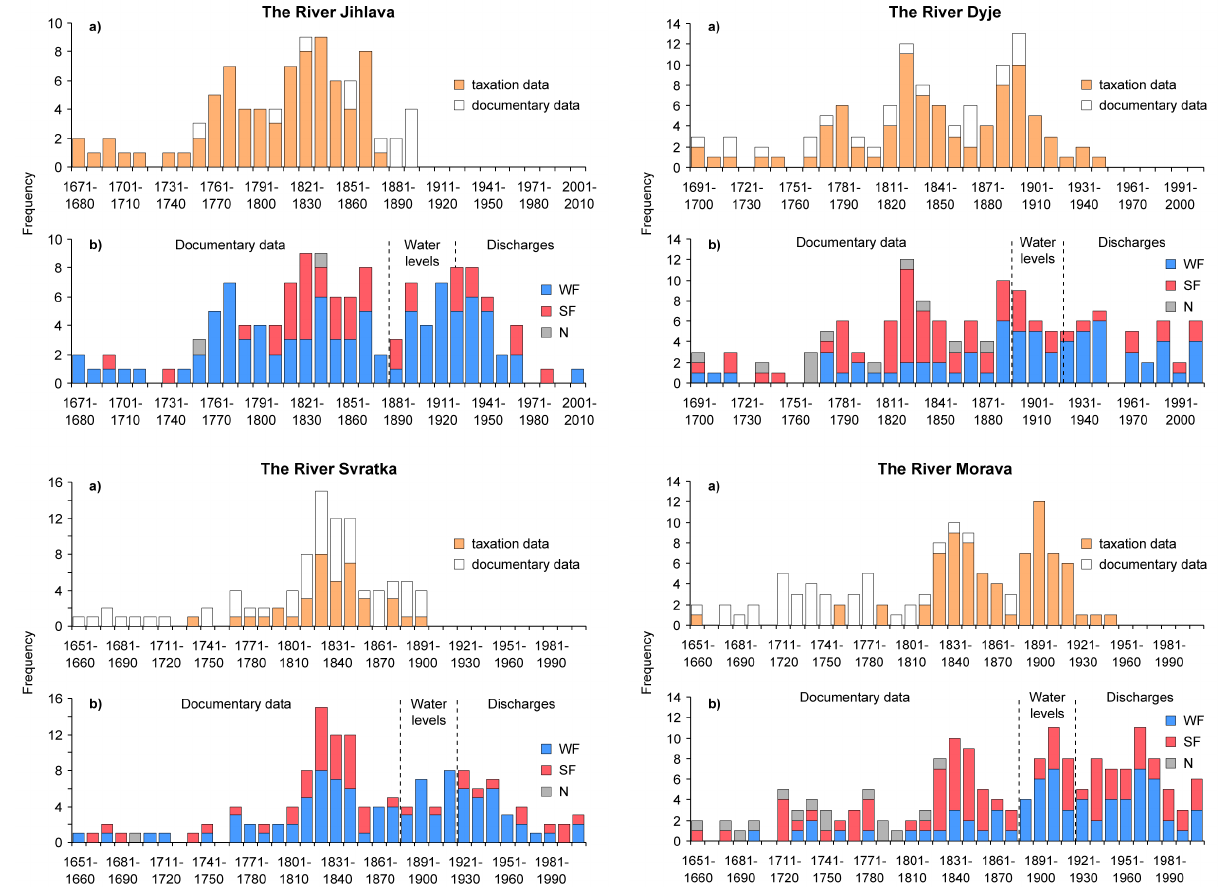
Figure 6. Long-term series of decadal flood frequency combining data derived from documentary (taxation and other documentary data) and instrumental (water levels, discharges) data for the Jihlava, Svratka, Dyje and Morava rivers in South Moravia: (a) series based on documentary data, (b) series compiled from documentary and instrumental data (WF – winter flood, SF – summer flood, N –